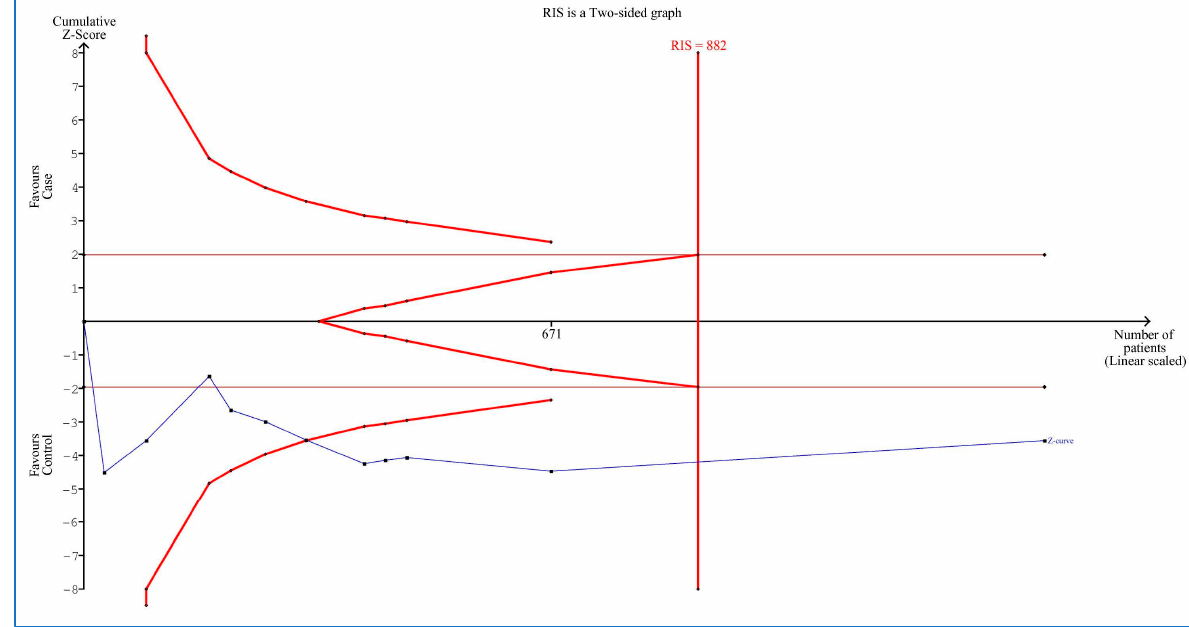
boundary for benefit (up) and for harm (down). Each black dot on the Z-curve (blue line) shows one line) shows one study